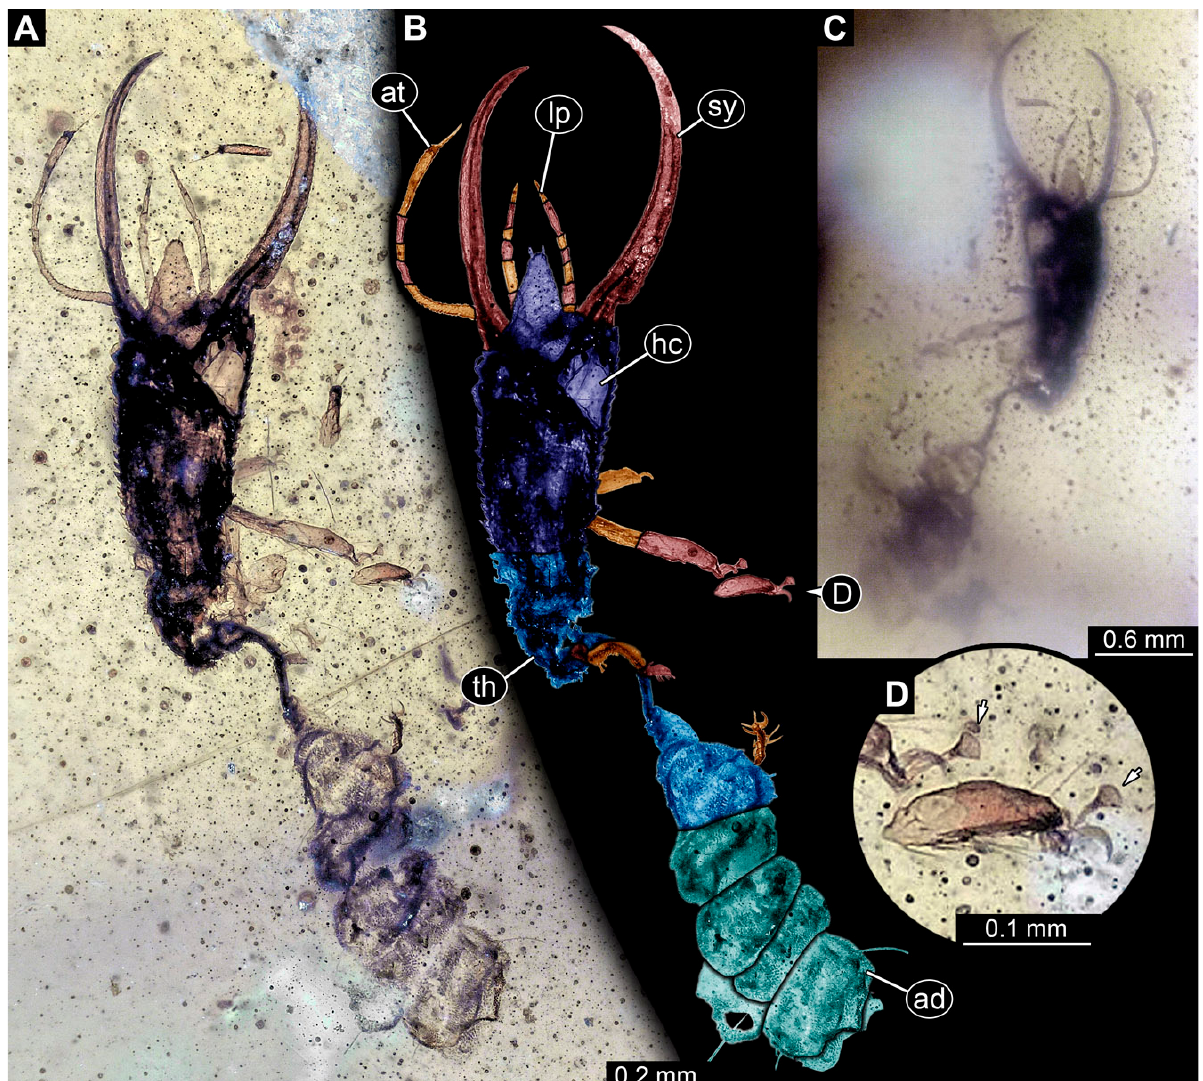
Figure 24. Specimen 89 (PED 2056); Myanmar amber. ( A ) Dorsal view. ( B ) Dorsal view, colour-marked. ( C ) Ventral view. ( D ) Close-up of locomotory appendages; arrows mark empodia. Abbreviations: ad = abdomen; at = antenna; hc = head capsule; lp = labial palp; sy = stylet; th = thorax.